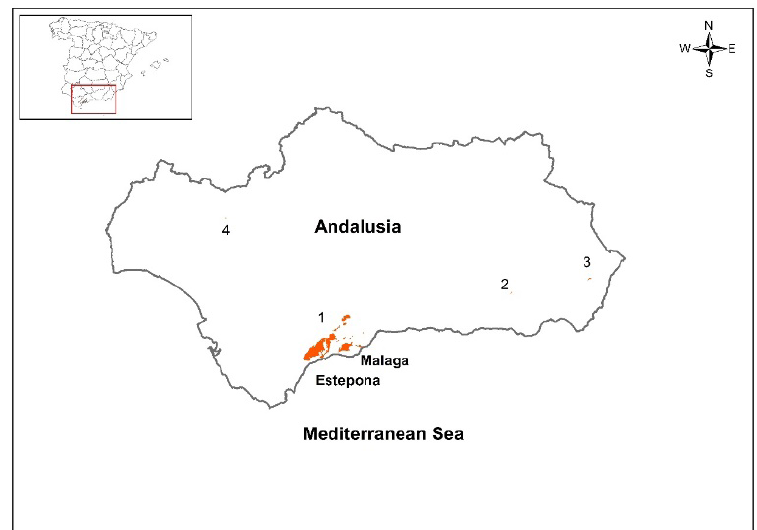
Figure 1. Ultramafic outcrops in the southern Iberian Peninsula (Andalusia) and their corresponding areas. 1: Sierras Bermejas (Malaga, 434.5 km 2 ). 2: Pico del Almirez (Sierra Nevada, Granada, 3 km 2 ). 3: Lubrín (Almeria, 3 km 2 ). 4: El Ronquillo (Seville, 1 km 2